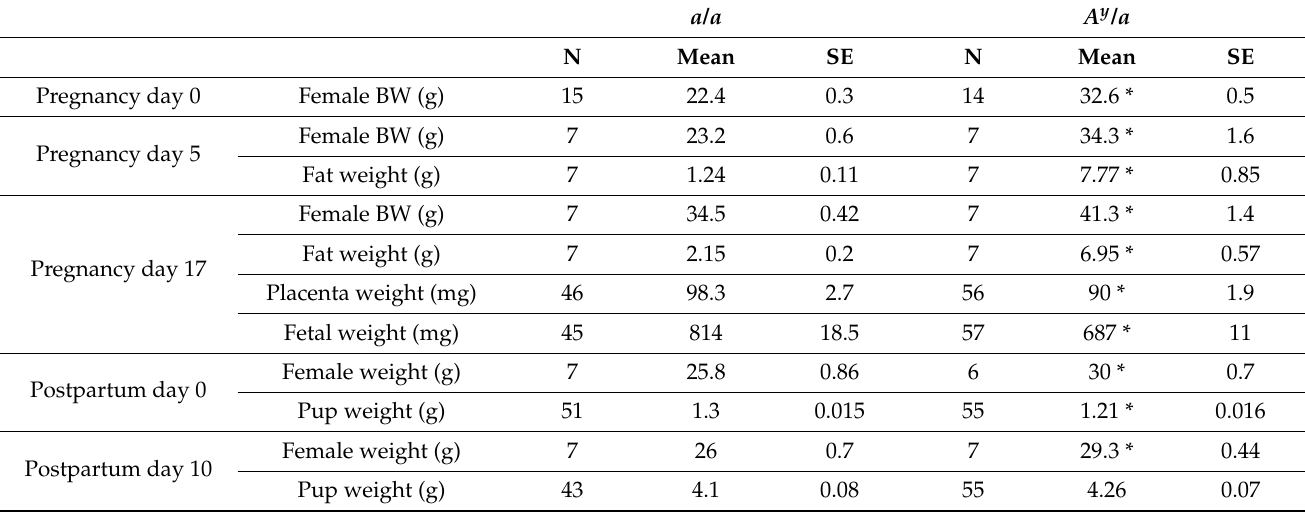
Table 1. Weight characteristics of females and their offspring during pregnancy and